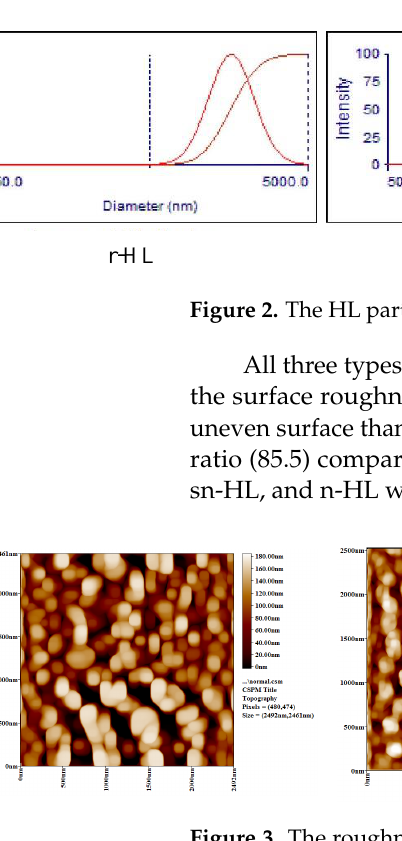
Figure 3. The roughness/topography of three types of HL measured by AFM ( a ) r-HL ( b ) sn-HL, ( c ) n-HL.